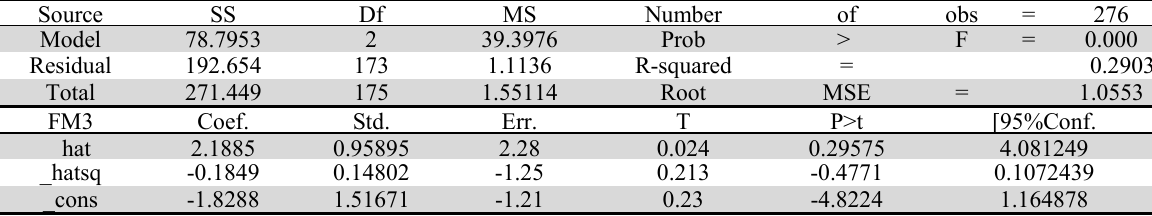
Turnover rate of accounting and Finance personnel (FM3)